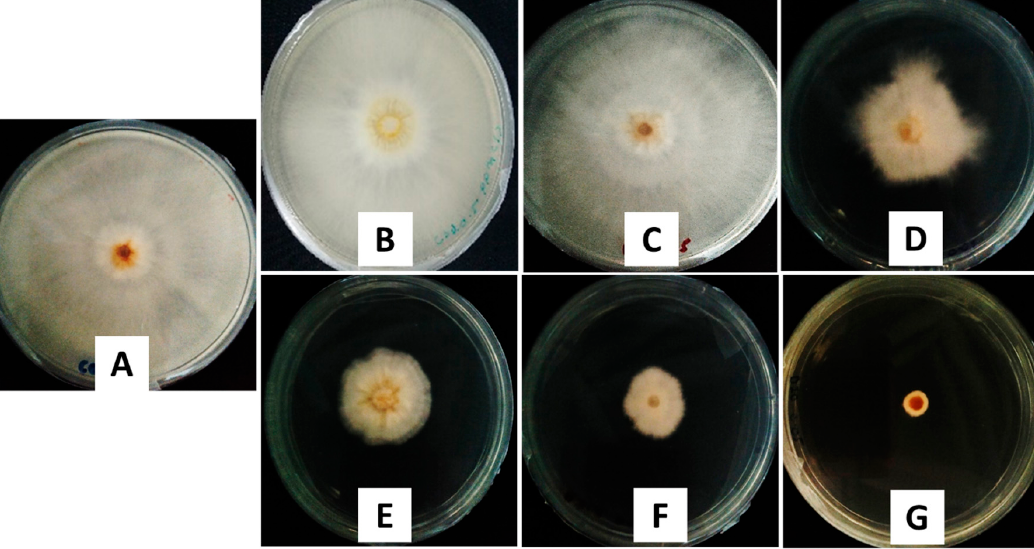
Figure 7. Antifungal effect on G. boninense of the ( A ) control, ( B ) chitosan, ( C ) pure dazomet, and chitosan-dazomet nanoparticles prepared at various concentrations of TPP: ( D ) 2.5, ( E ) 5, ( F ) 10, and ( G ) 20 mg/mL at 50 ppb concentration, 7 days after incubation at 28 ± 2 °C.